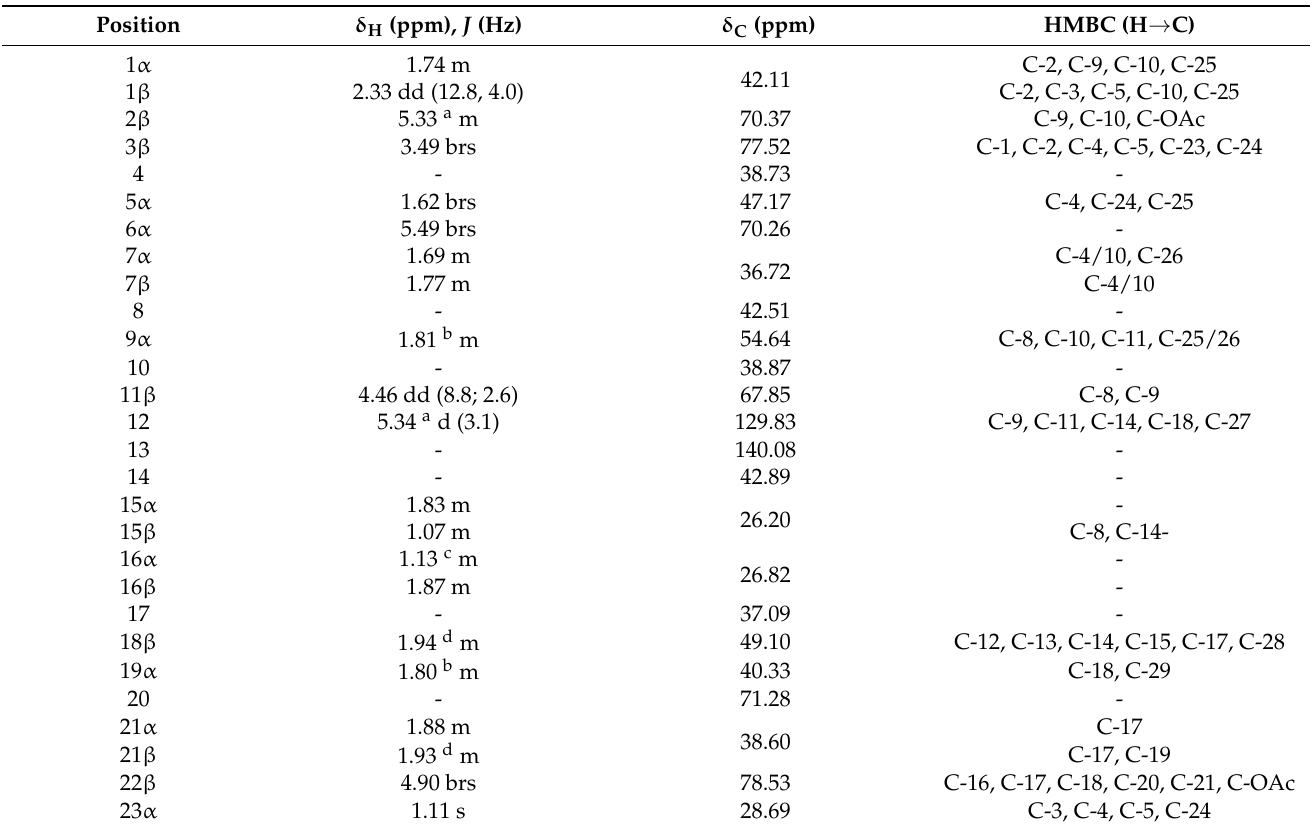
Table 2. 1 H NMR (400.17 MHz) and 13 C NMR (100.63 MHz) data of compound 2 in CDCl 3